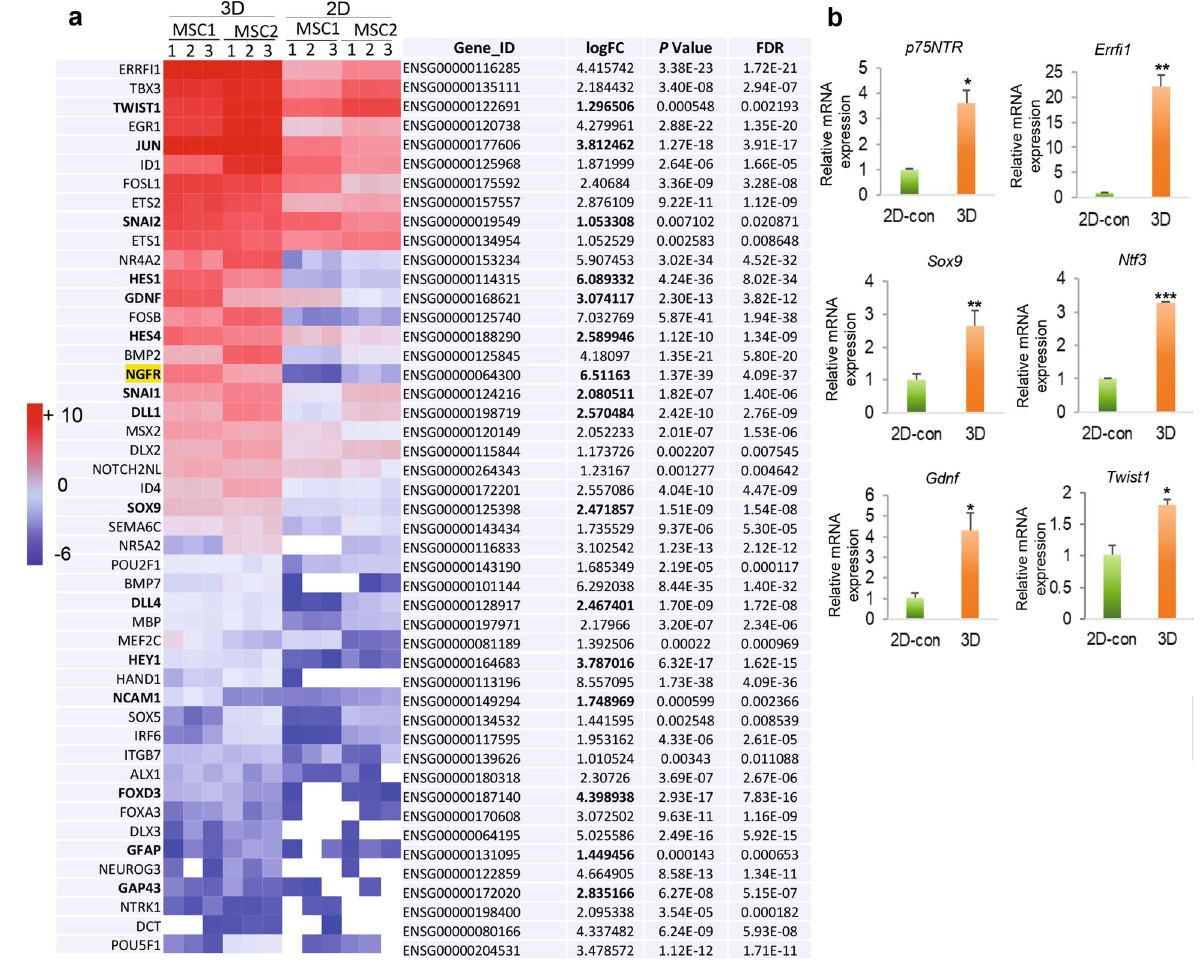
Fig. 3 RNA-seq on the expression pro fi le of neural crest and Schwann cell precursor cell-related genes in GMSCs cultured in methacrylated 3D-collagen hydrogel. GMSCs were encapsulated in 3D-collagen hydrogel (4 mg/mL) at a cell density of 2 × 10 6 /mL and cultured in complete α -MEM for 48 h. Total RNA was extracted from 2D- and 3D-cultured GMSCs for next-generation RNA-seq or qRT-PCR. a Heatmap illustrates NCSC/SCP-like cell-related genes that are signi fi cantly upregulated across all samples of GMSCs cultured in 3D collagen hydrogel as compared to the paired 2D-cultured GMSCs (triplicates in two-pairs of GMSCs). The red represents high expression and blue represents low expression. logFC, log2 (fold change; 3D-cultured GMSCs over those 2D-cultured). b The upregulation of several NCSC-related genes in GMSCs cultured in 3D-collagen hydrogel was con fi rmed by quantitative RT-PCR as compared to those in 2D-cultured GMSCs as controls (2D-con). Data represent the mean ± SD, n = 3 biological replicates. * p < 0.05; ** p < 0.01; *** p < 0.001. Student ’ s two-tailed unpaired t -test ( b ). 2D or 2D-con, GMSCs cultured in 2D-conditions; 3D, GMSC cultured in 3D-collagen